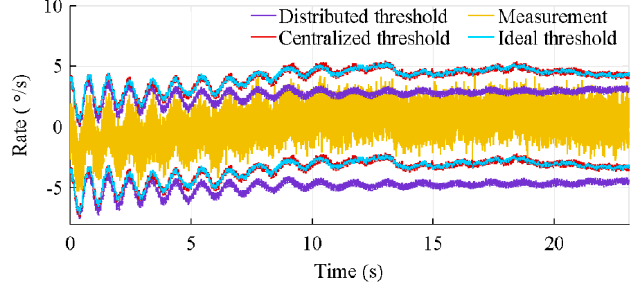
Figure 12. Typical 4𝜎 thresholds of the centralized and distributed architectures with the algorithms considering sensors location, for 27 IMUs.